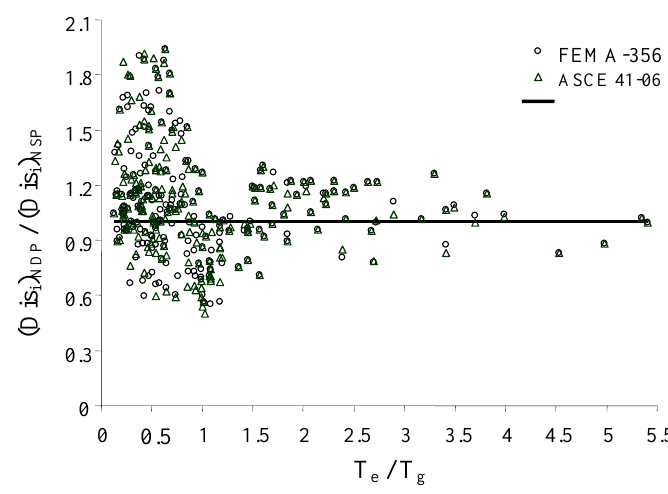
)Dis( for every four soils in selected )Dis( / NSPi NDPi